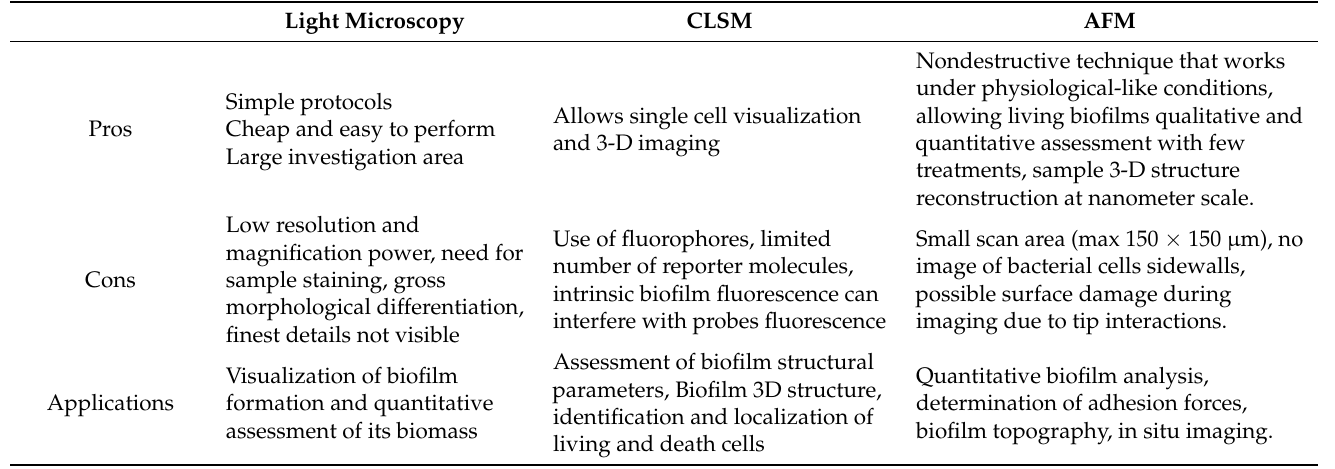
Table 1. Most widely used non-electron microscopic techniques for biofilm